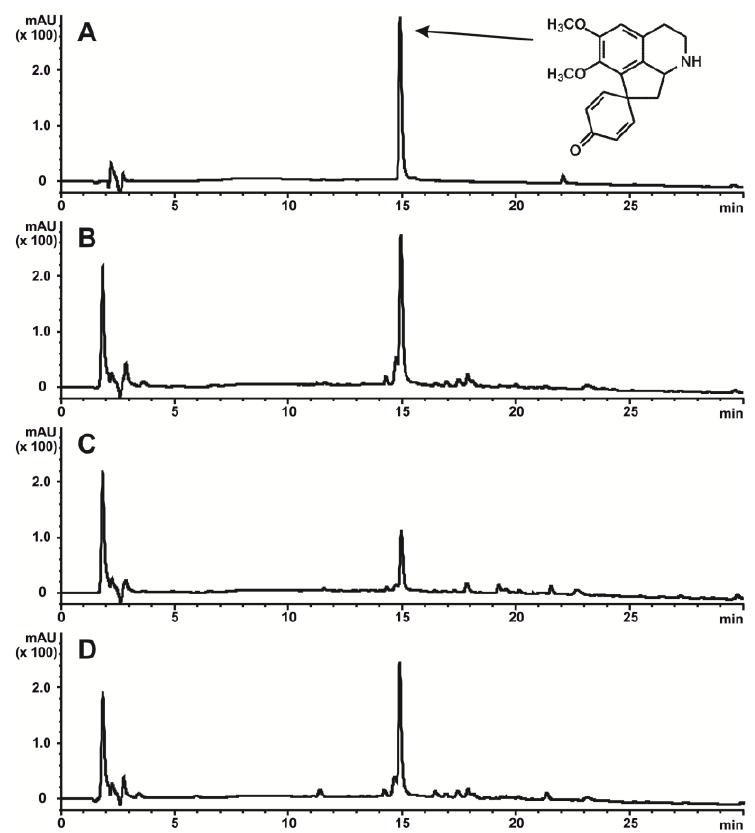
Figure 4. A representative HPLC-UV profile of the extracts obtained from cells of S. glabra (recorded at 237 nm). ( A ) The profile of the standard solution of stepharine and its molecular structure. ( B ) The extract from the nodules with roots of the S2 culture. ( C ) The extract from the nodules with roots of the S3 culture. ( D ) The extract from the nodules with roots of the S4 culture.